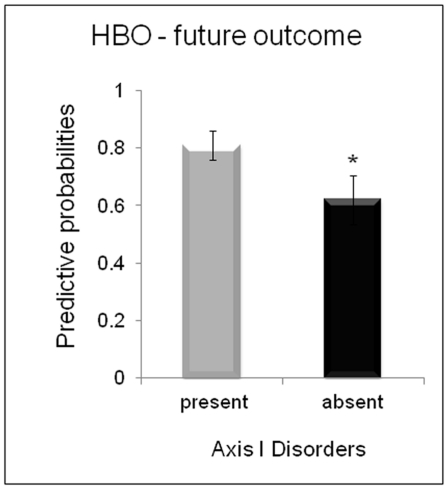
Mean predictive probabilities (with standard error to the mean) for the comparison between healthy bipolar offspring with and without future onset of Axis I disorder, which in this sample was major depressive disorder and anxiety disorders.